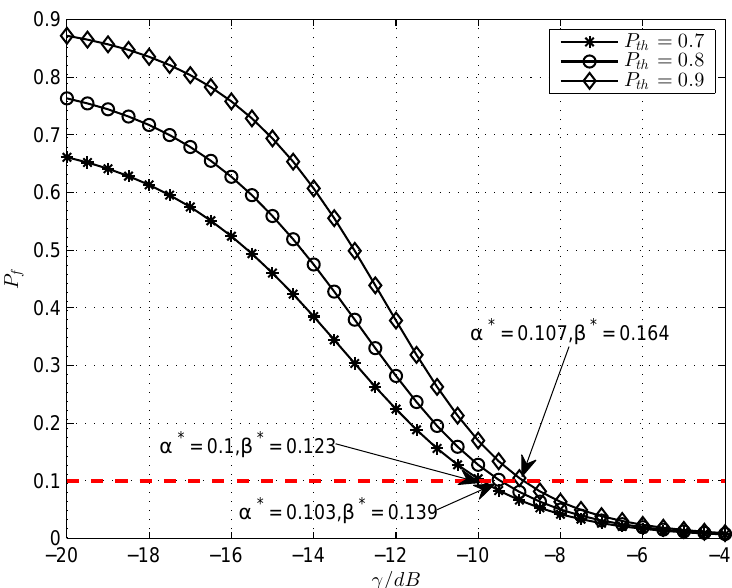
Figure 5. Probability of false alarm P f vs. γ , for different ¯ P th